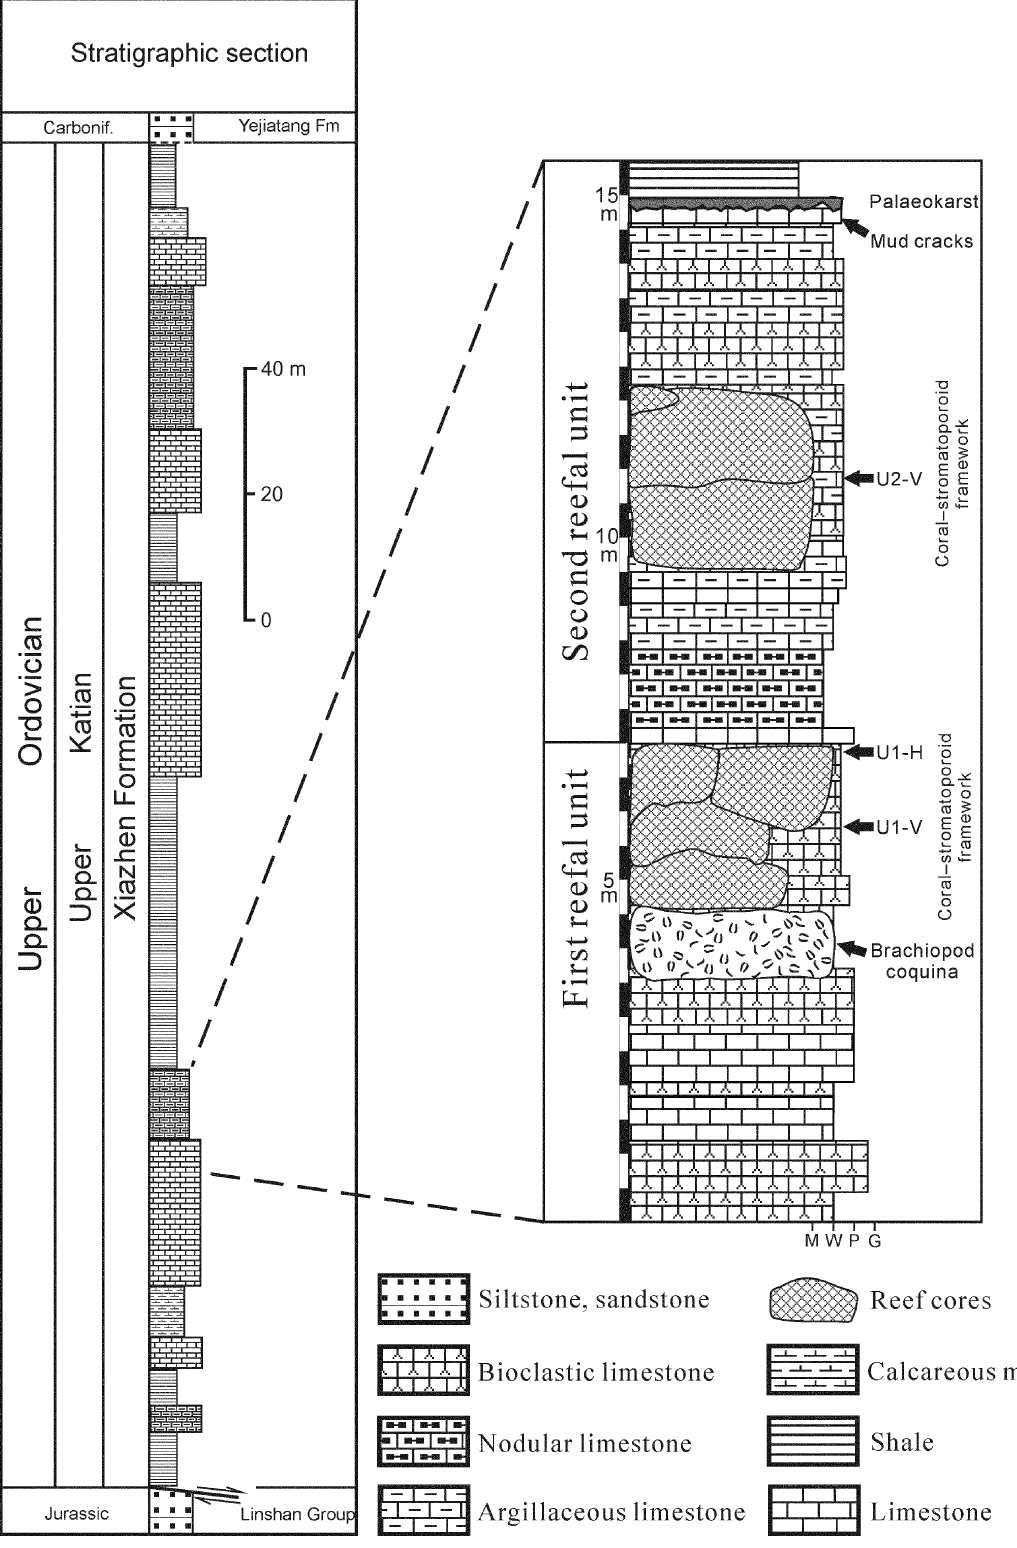
Fig. 1. Lithologic column of the Xiazhen Formation at Zhuzhai (modified from Zhan et al. 2002) and the two reefal units in its lower part. M, mudstone; W, wackestone; P, packstone; G,